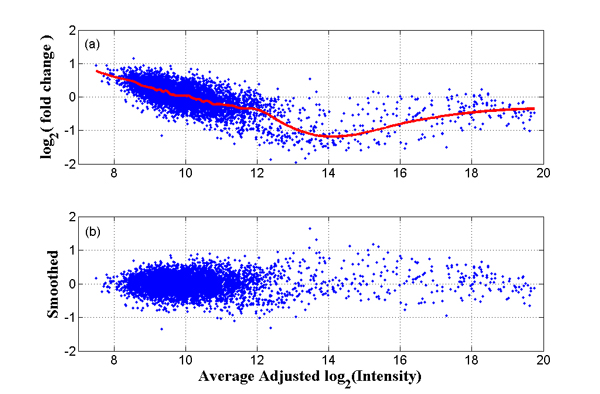
Scatter plot of estimated fold-changes before (a) and after (b) Loess smoothing. Figure 2a plots 5,352 estimates of the gender difference in expression from the analyses of covariance. These estimates are for 'Block 5' and the genes interrogated on array type, GF201. The red line is the trend estimated by Loess regression. Figure 2b plots these data after removing the trend.